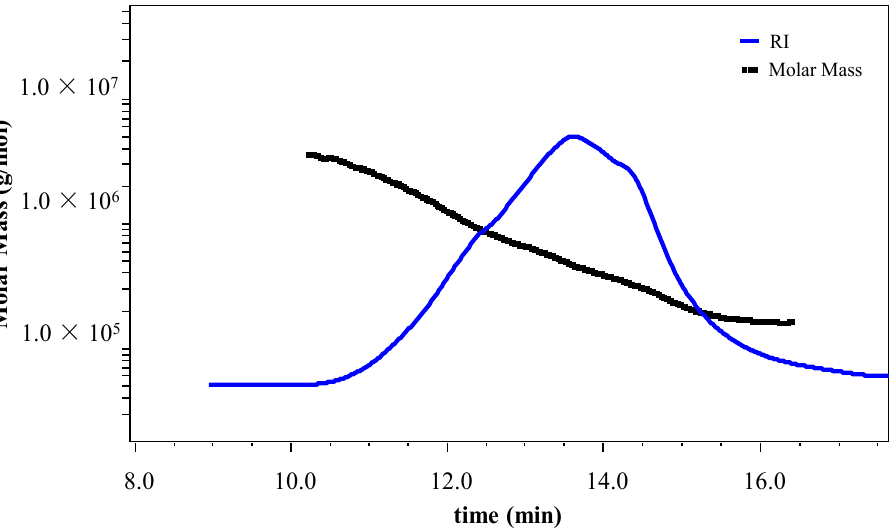
Figure 1. Molecular weight distribution depicted by HPSEC-Visc-MALLS-RID of G. blodgettii polysaccharide.